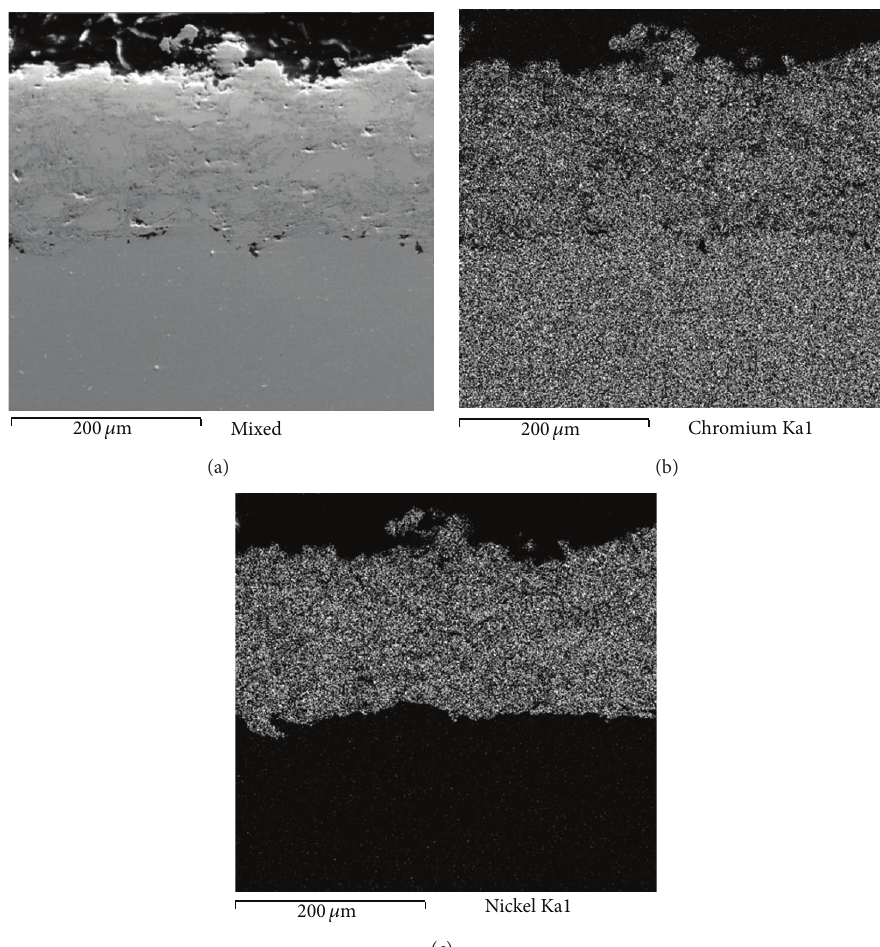
Figure 3: Cross-section aspect of the coatings and elements mapping.